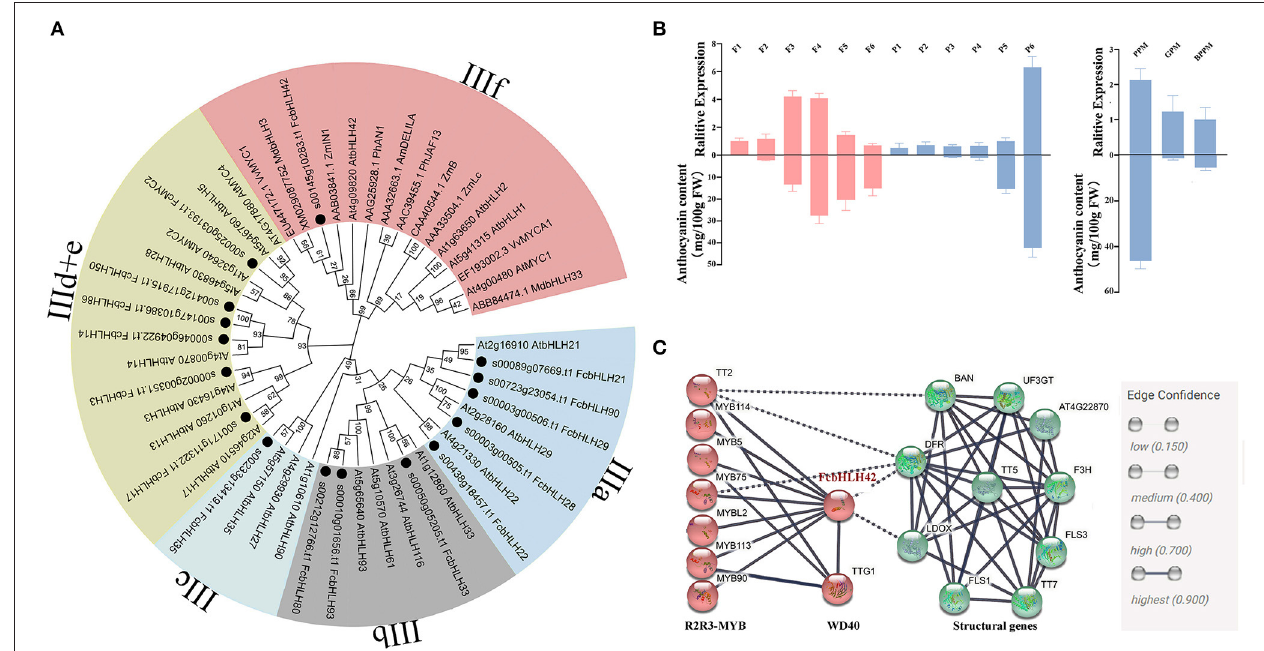
FIGURE 5 | Subgroup III FcbHLHs: phylogenetic tree analysis, expression profile, and interaction network of FcbHLH42. (A) NJ phylogenetic analysis of subgroup III FcbHLHs, AtbHLHs and bHLHs of other species. Different colors indicate different subgroups, and black dots indicate FcbHLHs. (B) Expression heat maps of 16 FcbHLH genes of subgroup III. After log 2 conversion, log 2 FC > 0 indicates upregulation, and log 2 FC < 0 indicates downregulation. F1–F6 and P1–P6 represent the six stages of female flower and fruit peel development, respectively. GPY and GPM, peel of young and mature “Green-Peel” fruits, respectively. PPY and PPM, peel of young and mature “Purple-Peel” fruits, respectively. PFM, female flower of mature “Purple-Peel” fruit. BPPM and BPFM, peel and female flower of mature “Purple-Peel” fruits that were bagged at the young stage. (C) Interaction network of FcbHLH42 from the perspective of Arabidopsis thaliana homologous genes. Red represents transcription factors, and green represents key synthase